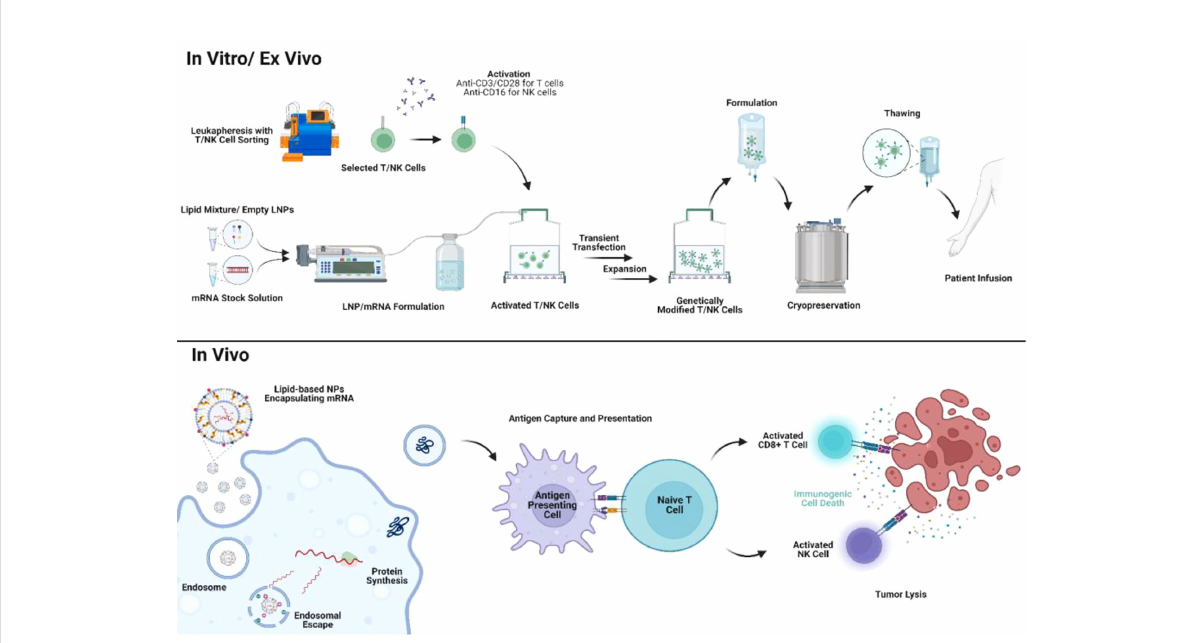
FIGURE 4 Application of mRNA/lipid-based NPs in mRNA therapies and cell therapies. mRNA/lipid-based NPs can be utilized for engineering cell therapy ex vivo with shortened manufacturing timeline and reduced physiological side effects. In addition, mRNA/lipid-based NPs can also be directly delivered in vivo to either engineer immune cells or as exogenous tumor